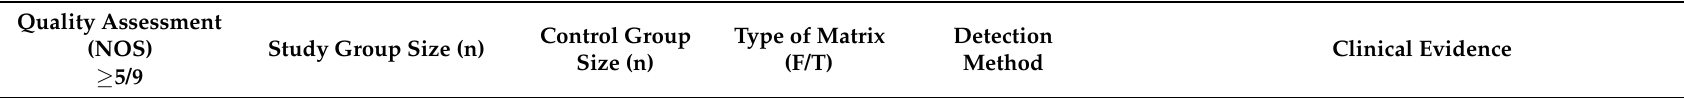
Table 1. Summary of human studies investigating precancerous colorectal lesions and healthy control stool and tissue specimens addressing microbial composi- tional